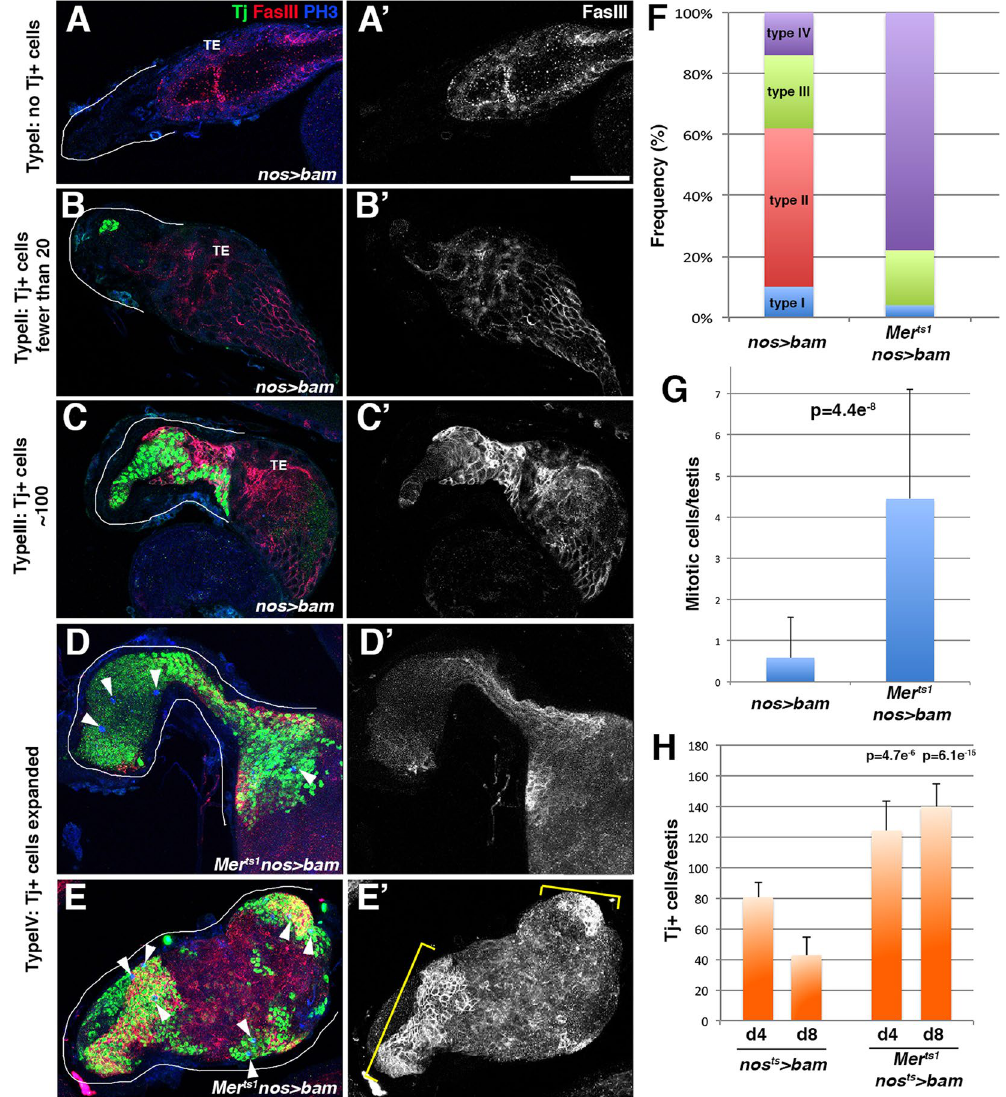
Figure 6. Mer is required to prevent CySC/CC overproliferation in the germ cell-depleted testis. ( A – C ) The apical tip of the testis from nos > bam stained for Tj, FasIII, and phosphorylated histone H3 (pH3). The testis apical region is marked by white lines. Terminal epithelium (TE). Bar, 50 µ m. ( D and E ) The apical tip of the testis from Mer ts1 nos > bam . Overproliferated Tj + cells stained for FasIII (D’ and E’). Arrowheads indicate mitotic somatic cells. ( F ) Summary of the testis phenotype upon depletion of germ cells in the wild-type or Mer ts1 background. Types I–IV correspond to the designations in A–E. n ≥ 27 testes for each data point. ( G ) The mitotic index in testes expressing bam in a wild-type or Mer ts1 mutant background. N = 30 testes for each data point. ( H ) The number of Tj + cells in wild-type and Mer ts1 background after induction of germ cell loss by expression of bam upon eclosion. N ≥ 10 testes for each data point. p values were obtained using the Student’s t test (two-tailed) by comparing to control at corresponding time